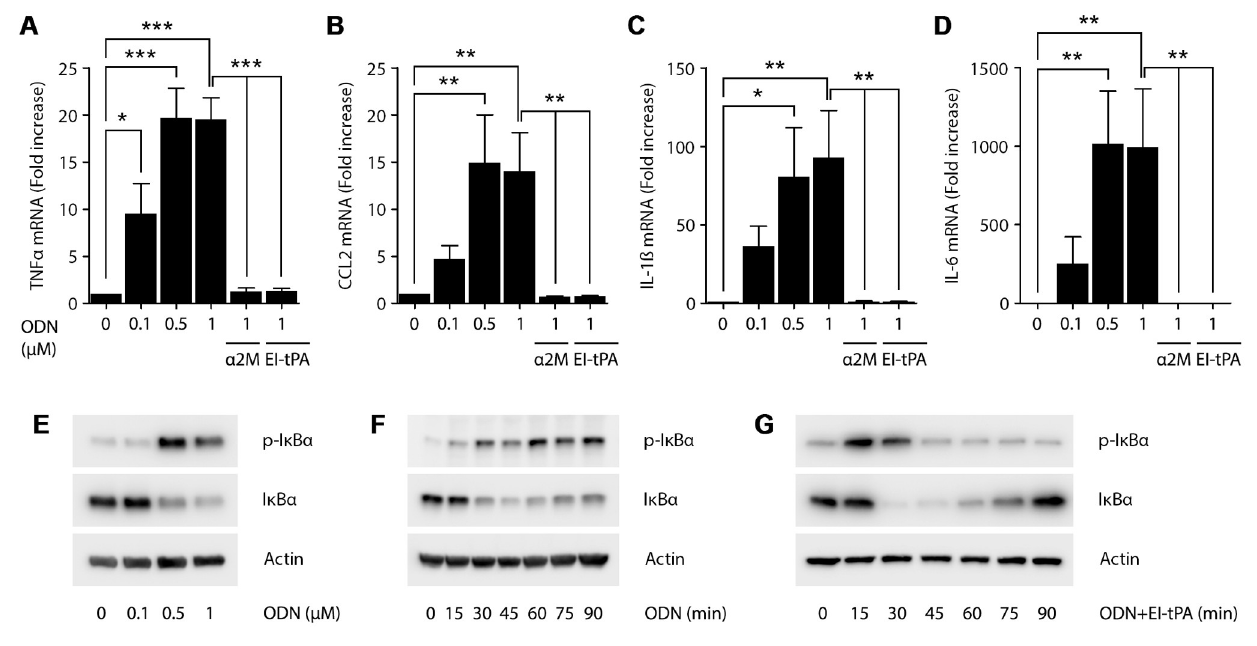
Fig 2. EI-tPA blocks TLR9-induced inflammatory response in BMDMs. BMDMs were treated with increasing concentrations of the TLR9 agonist, ODN 1826 (0.1–1 μ M), or with ODN 1826 (1 μ M) plus activated α 2M (10 nM) or EI-tPA (12 nM) for 6 h. RT-qPCR was performed to compare mRNA levels of (A) TNF α , (B) CCL2, (C) IL-1 β , and (D) IL-6 (mean ± SEM; n = 4–6; one-way ANOVA with Bonferroni post-hoc test on selected pairs of columns; � p < 0.05, �� p < 0.01, ��� p < 0.001). Immunoblot analysis showing total and phosphorylated I κ B α in BMDMs treated with: (E) increasing concentrations of ODN 1826 (0.1-1 μ M) for 1 h; (F) 1 μ M ODN 1826 for the indicated times; or (G) 1 μ M ODN 1826 in presence of 12 nM EI-tPA for the indicated times. β -actin levels are shown as control.